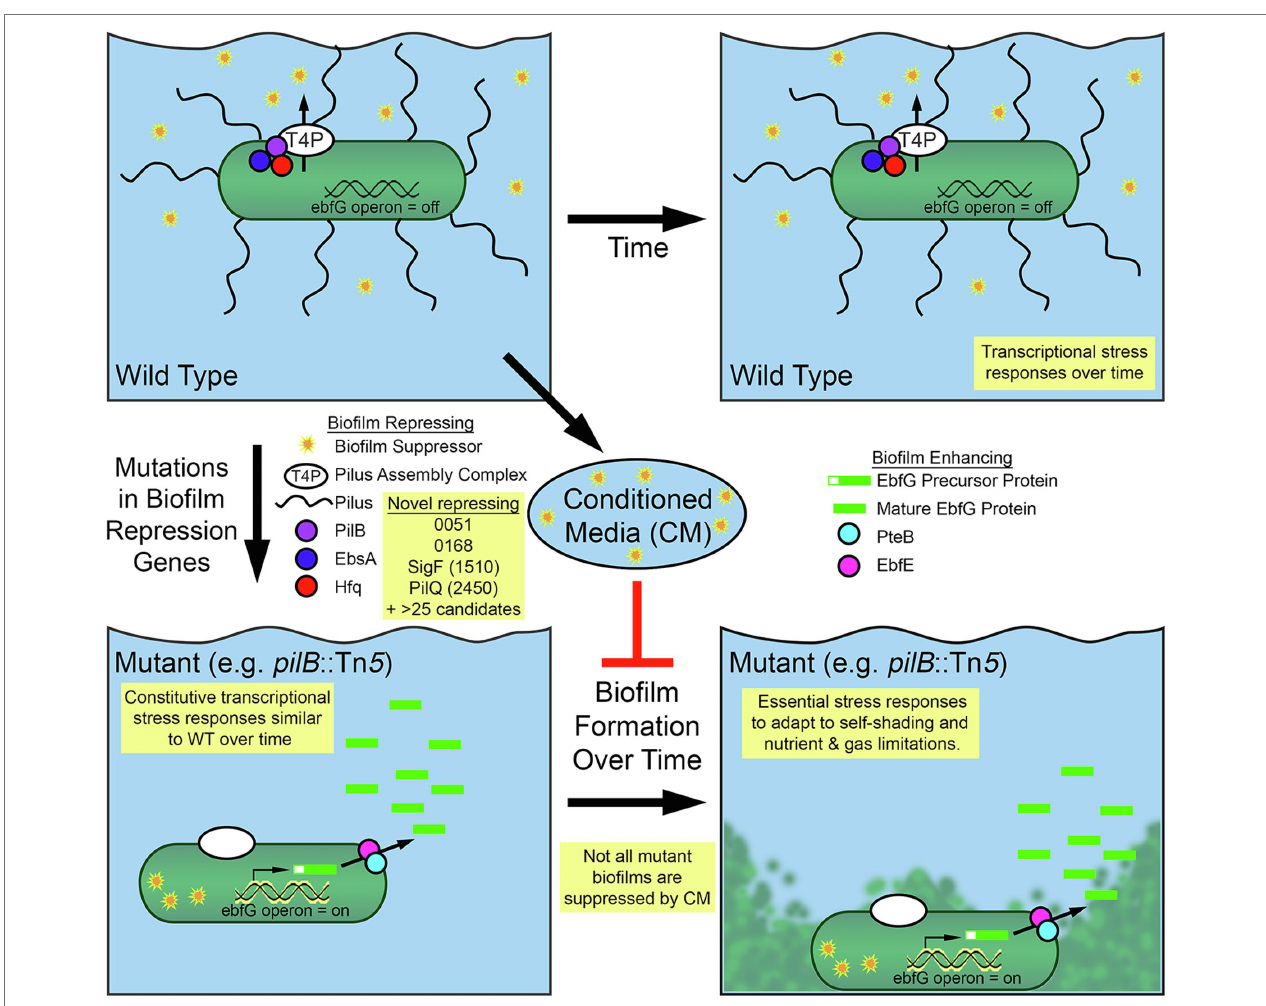
FIGURE 5 | Diagram of biofilm formation for Synechococcus elongatus PCC 7942. Self-suppression of biofilm formation in WT S. elongatus PCC 7942 is mediated by secretion through the type IV pilus (T4P) apparatus and its association with pili and a tripartite complex of the PilB, EbsA, and Hfq proteins. Suppressor present in conditioned media (CM) represses biofilm formation in some biofilm forming mutants. Removal of suppressing elements enables biofilm formation through the expression of the EbfG proteins and their processing and secretion, which involves PteB and EbfE. RNA-Seq and RB-TnSeq findings that add to this model are highlighted in yellow